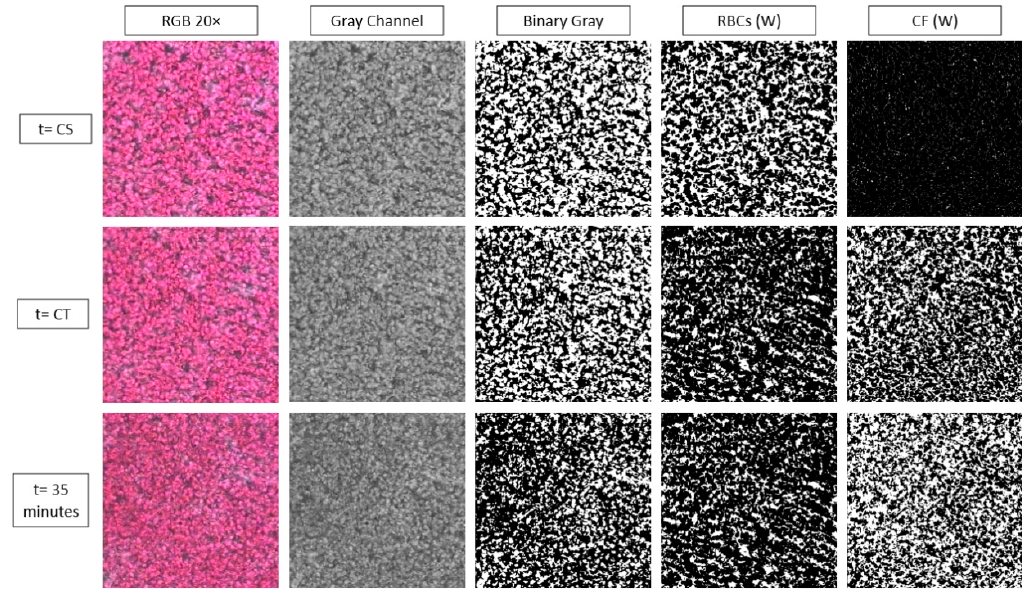
Figure 4. Representative images and the resulted red blood cell (RBC) and clot areas (CF) in white (W) pixels, on which the relevant indices are defined.